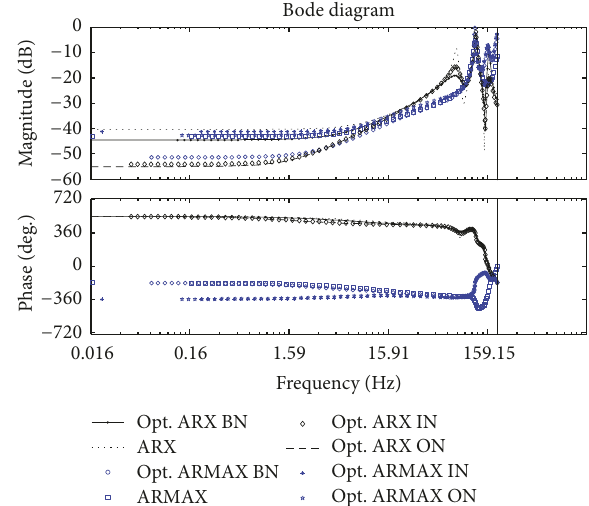
Figure8:BodeplotforARX(black)andARMAX(blue)realization; flow coefficient = 0.55. Data is filtered and resampled prior to system identification.